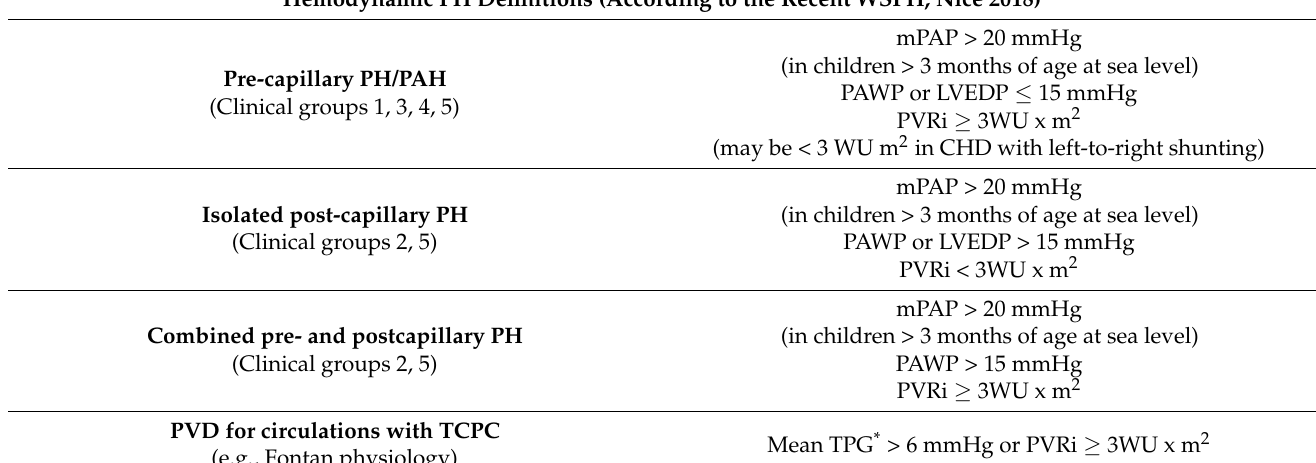
Table 1. Hemodynamic definitions of pulmonary arterial hypertension/pulmonary hypertension; (* Calculate for mean TPG mPAP—mLAP or PAWP).